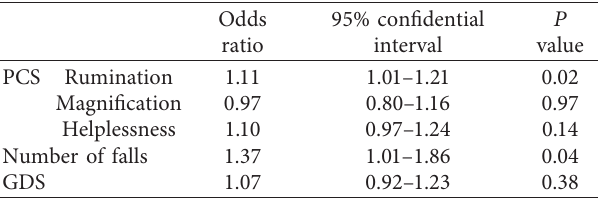
Table 2: Multiple logistic regression analysis for odds ratio and 95% confidence interval of chronic